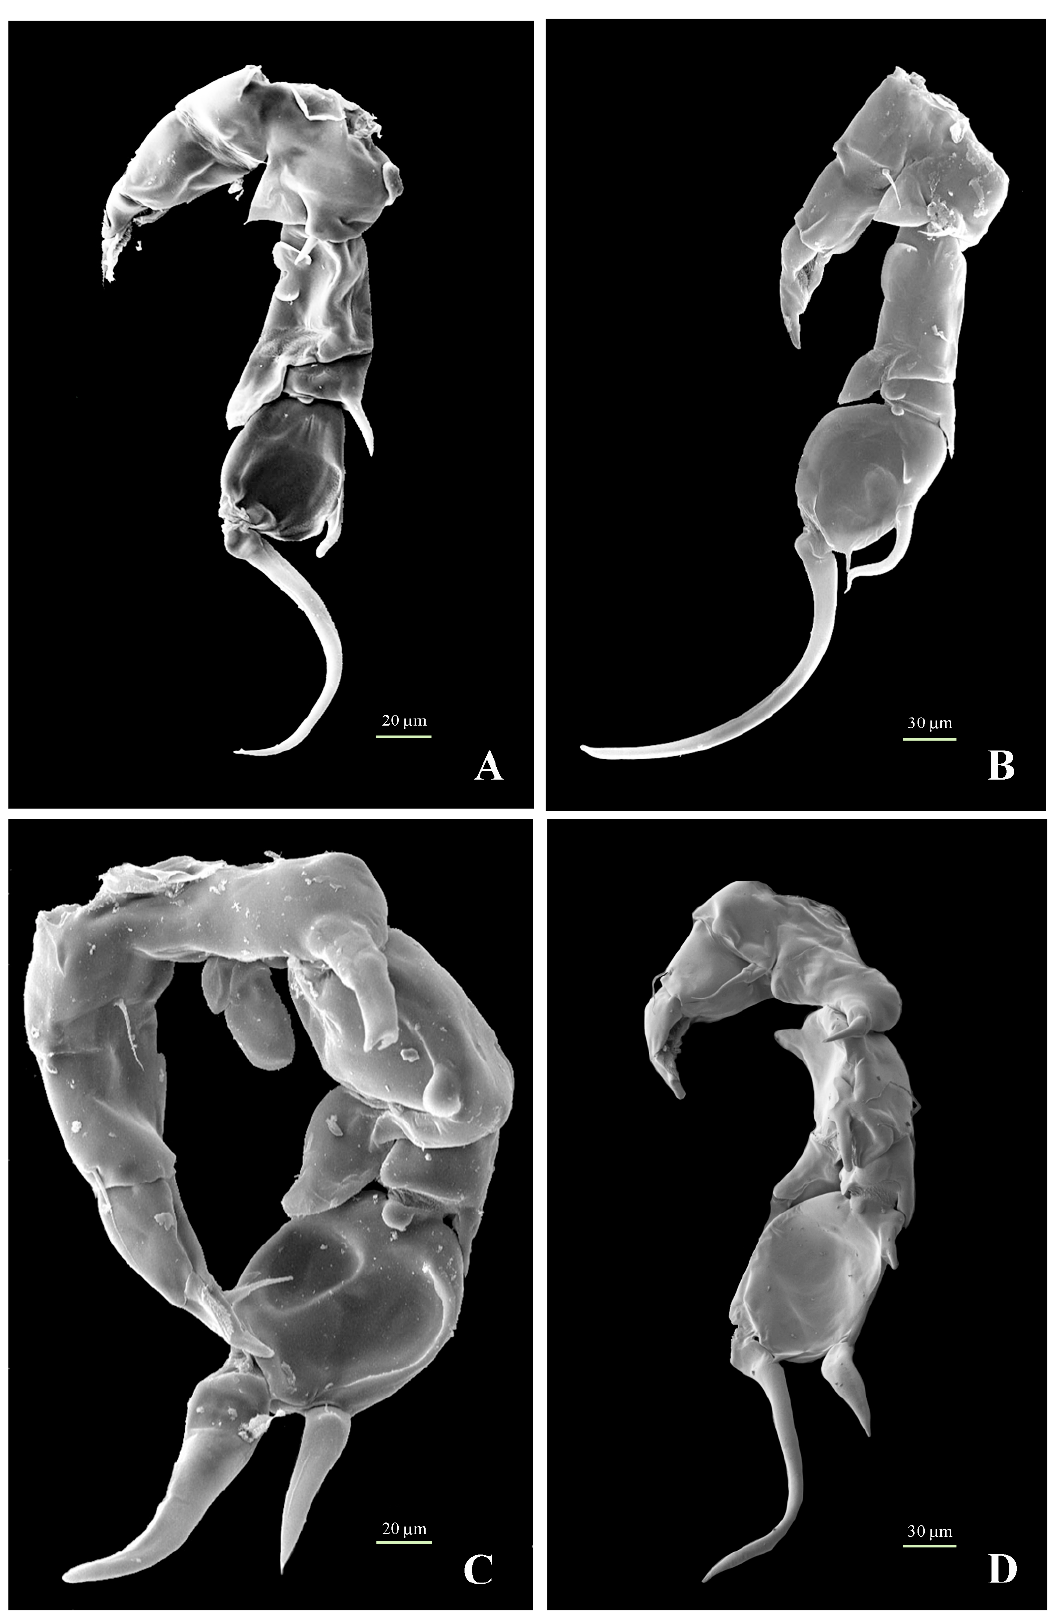
Figure 2. SEM photographs of the male leg 5 (P5) of four species of the genus Phyllodiaptomus : ( A ) P. (C.) praedictus ; ( B ). P. (P.) christineae ; ( C ). P. (P.) thailandicus ; and ( D ). P. (P.) roietensis.